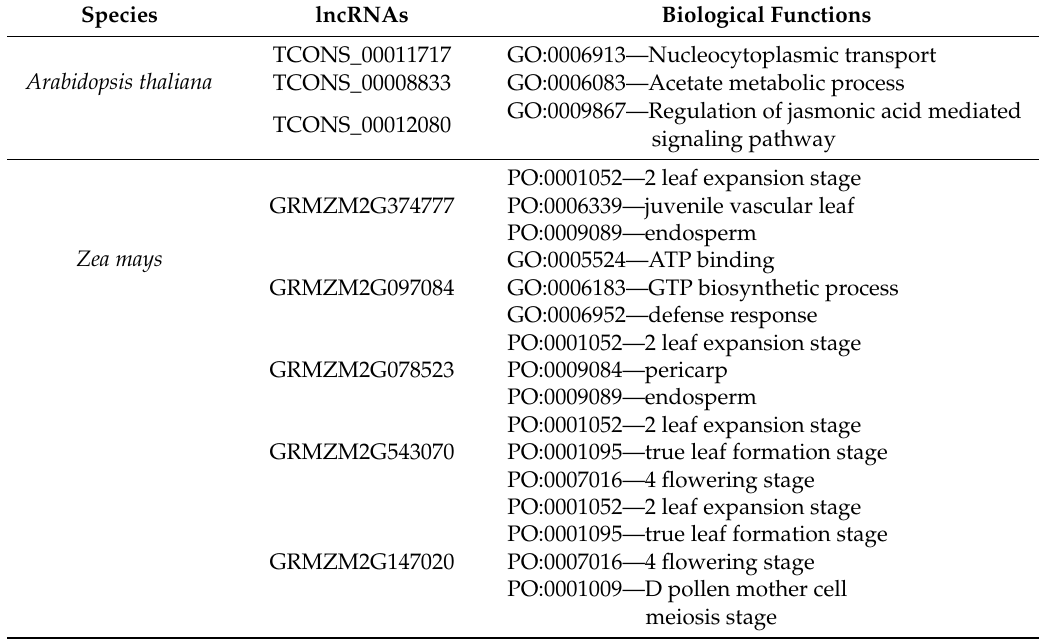
Table 6. Some selected Zea mays and Arabidopsis thaliana long non-coding RNAs (lncRNAs) and their biological